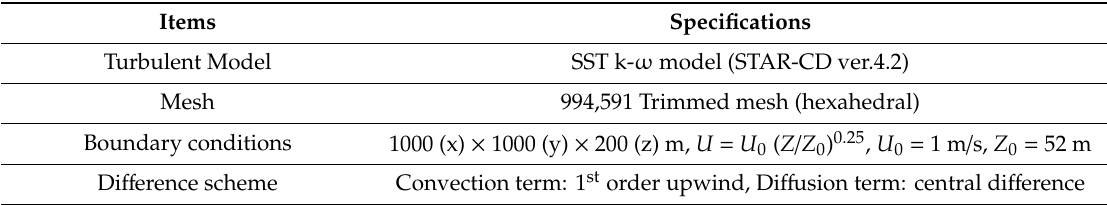
Table 2. Summary of calculation